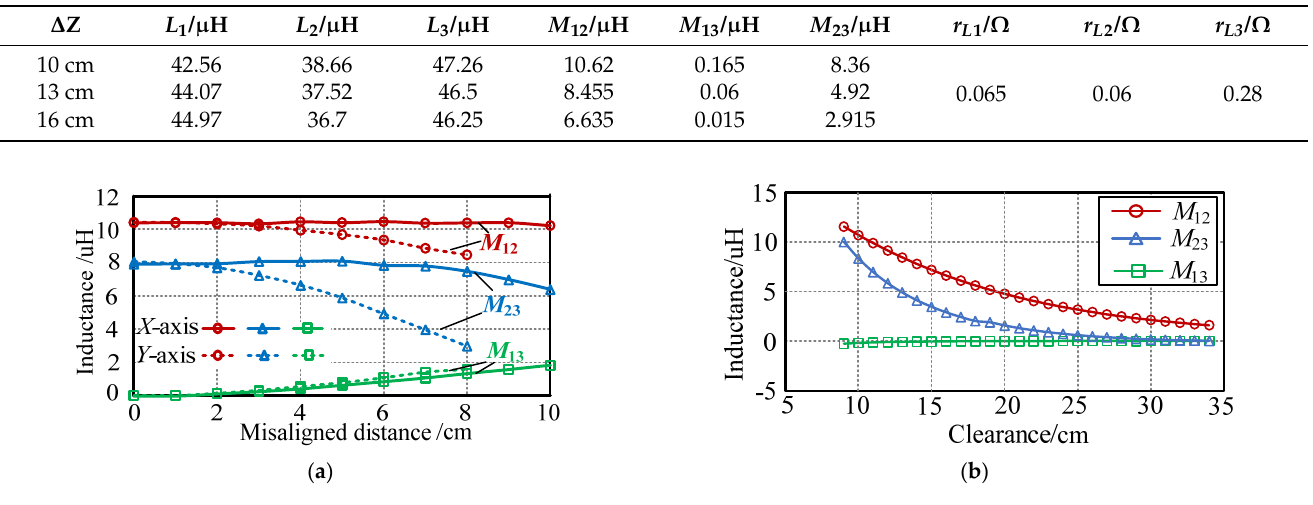
Figure 12. Measured mutual inductances of M 12 , M 23 , and M 13 under ( a ) misaligned conditions with ∆ Z = 10 cm and ( b ) different clearance conditions with ∆ X = ∆ Y = 0 cm.